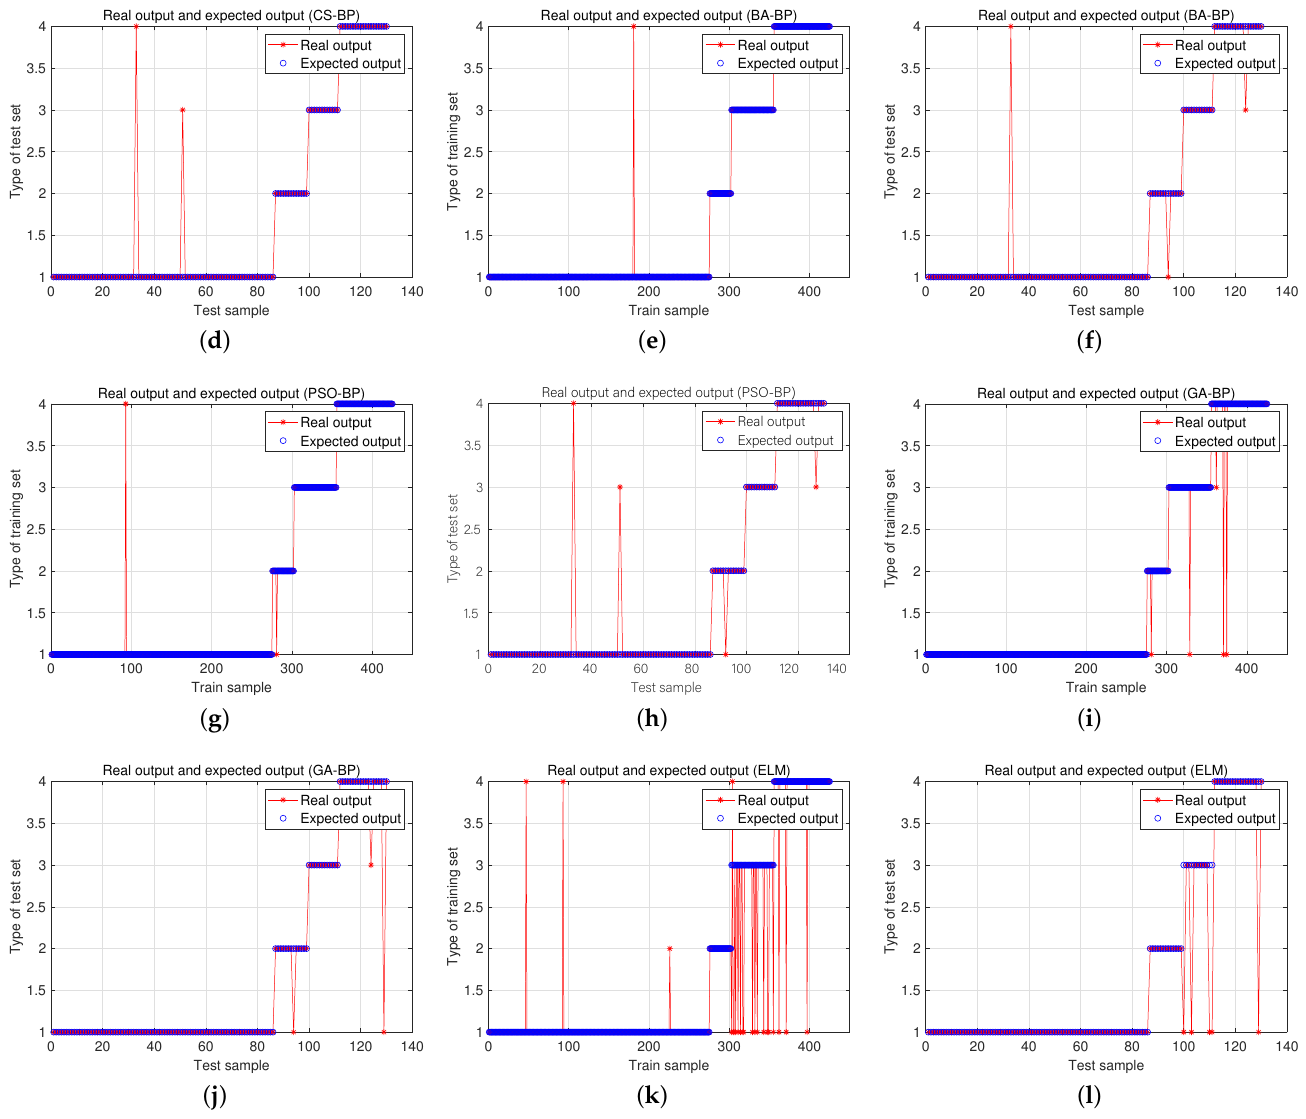
Figure 11. Comparison of the diagnosis results of the third set of comparative experiments. ( a , c , e , g , i , k ) represent the results of train sample classification for different methods, respectively. ( b , d , f , h , j , l ) are the results of test sample classification for different methods, respectively.